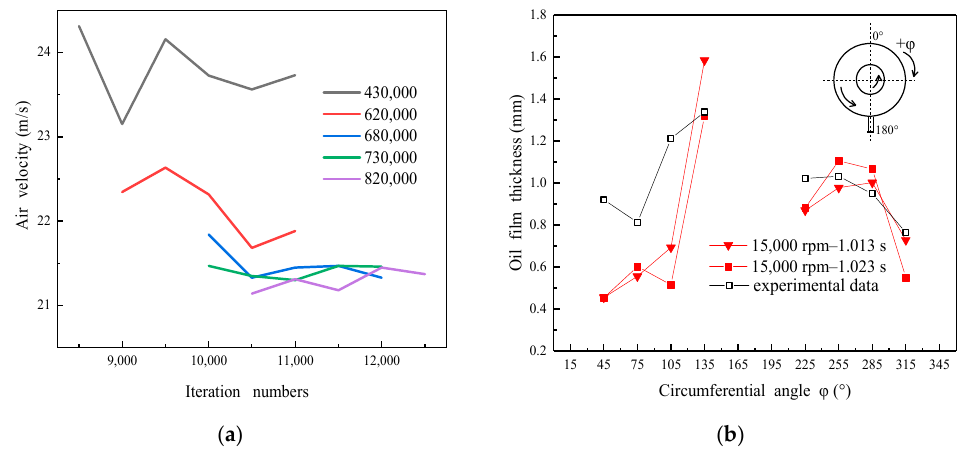
Figure 5. Grid independence ( a ) and model verification ( b ).